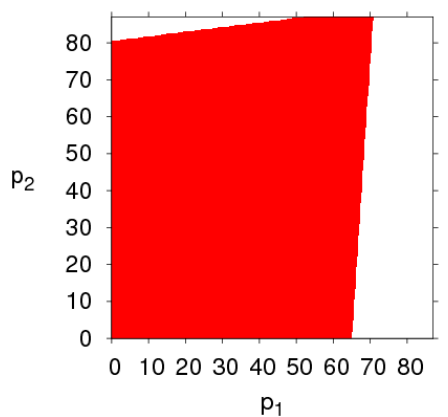
Figure 16. Basins of attraction of dynamic system (6), α 1 = α 2 = 0.005, k = 20.